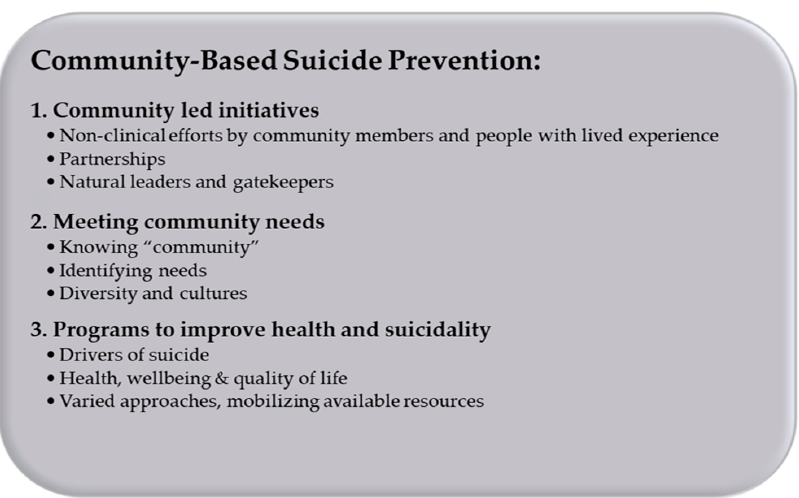
Figure 1. Thematic Groups and Subthemes Identified from Interview and Focus Group Data.